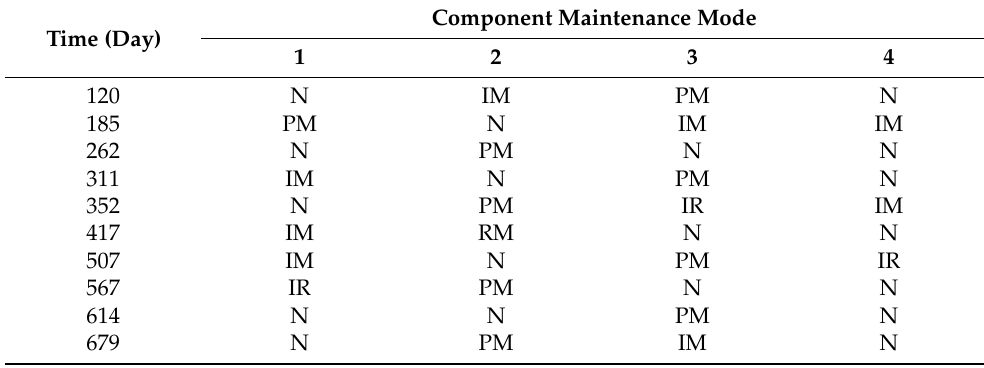
Table 9. Opportunistic maintenance scheme of the power transmission device.